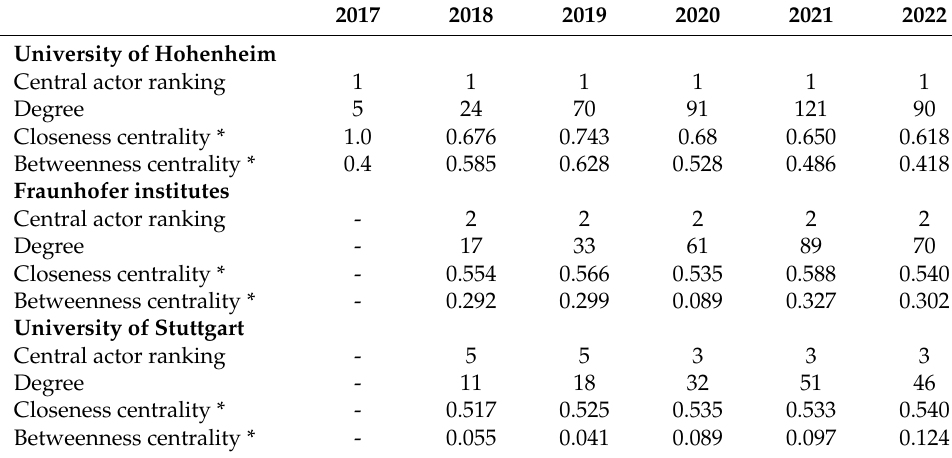
Table 4. Centrality measures of the three most central actors over